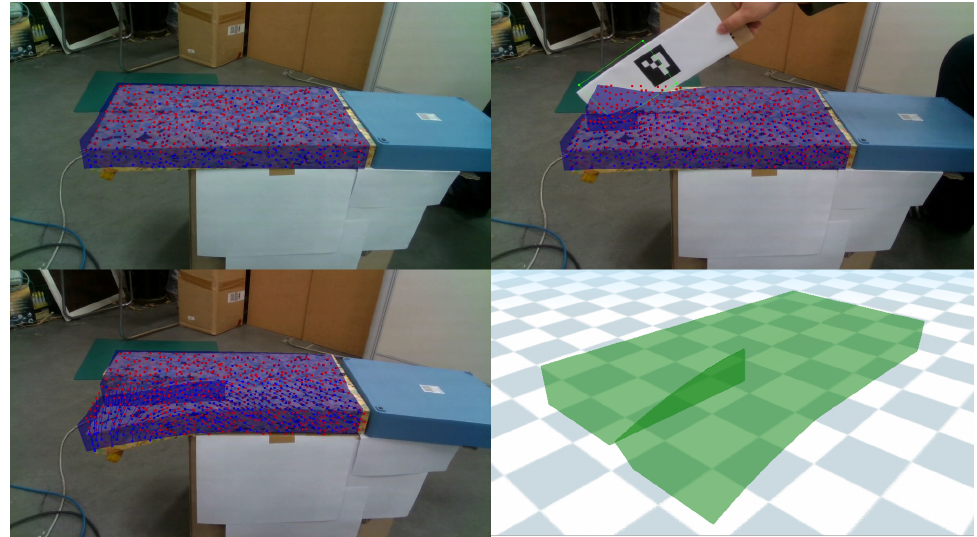
Figure 11. Topological deformation of a cuboid sponge: The sponge was cut by the marked board, which generated a reshaped mesh in real